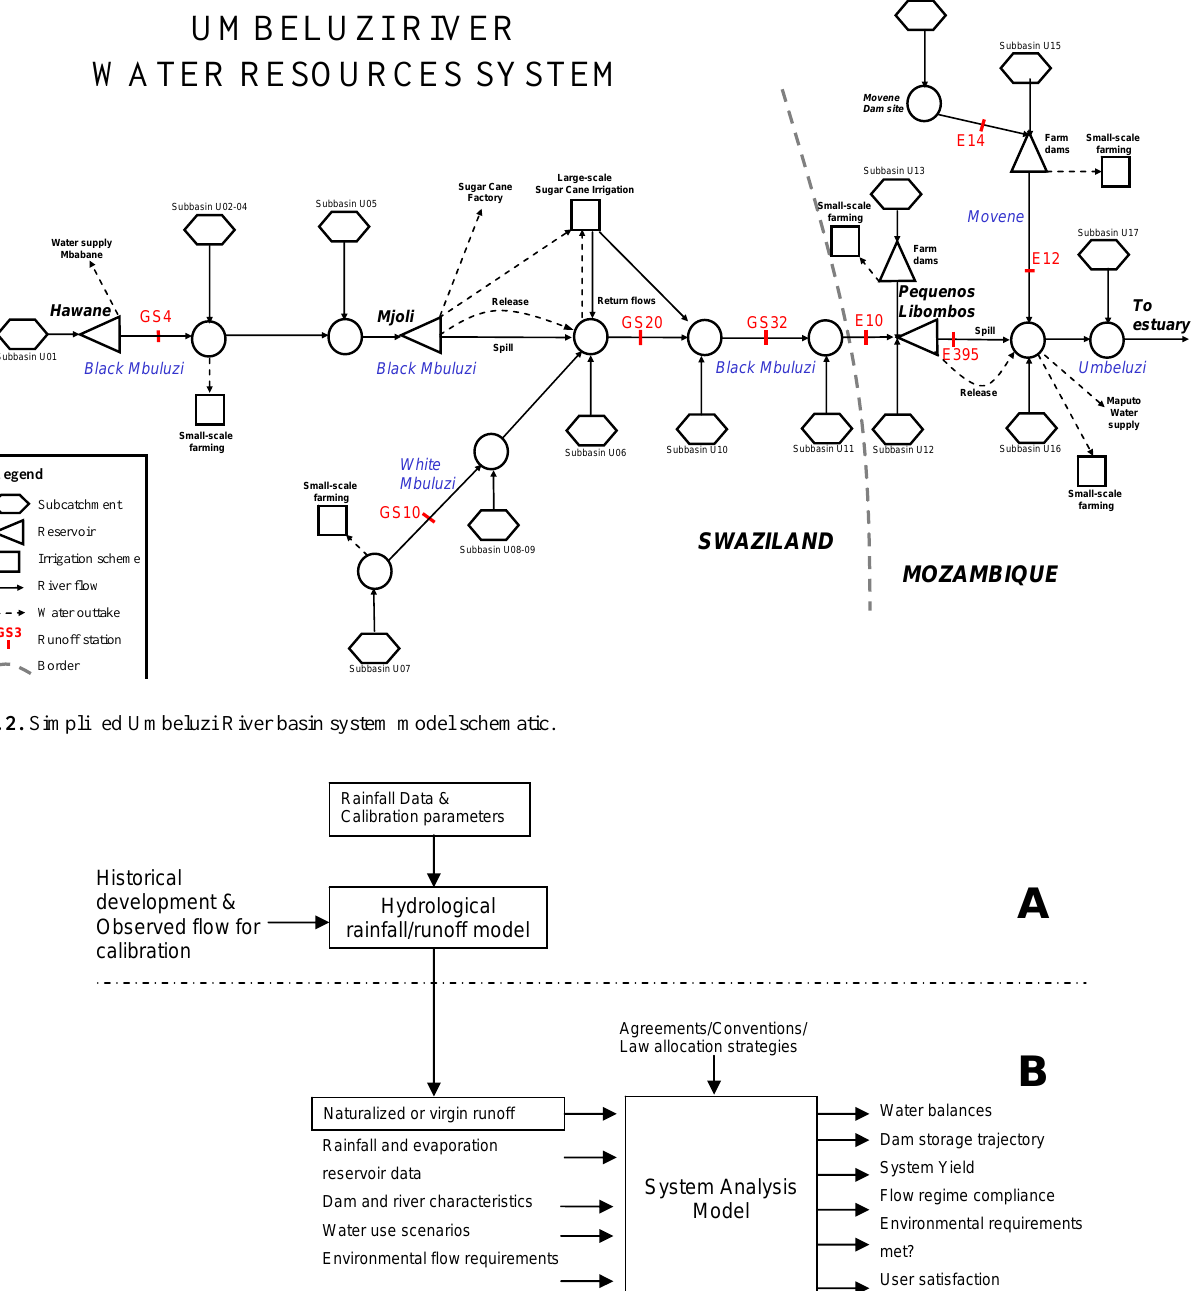
Figure 1 The Umbeluzi River basin